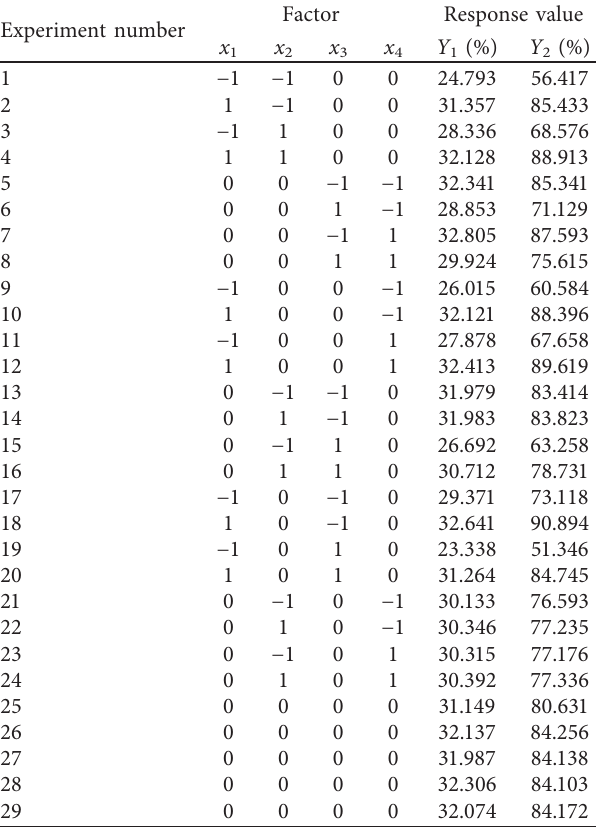
Table 3: Experimental design and response value. Factor Experiment number